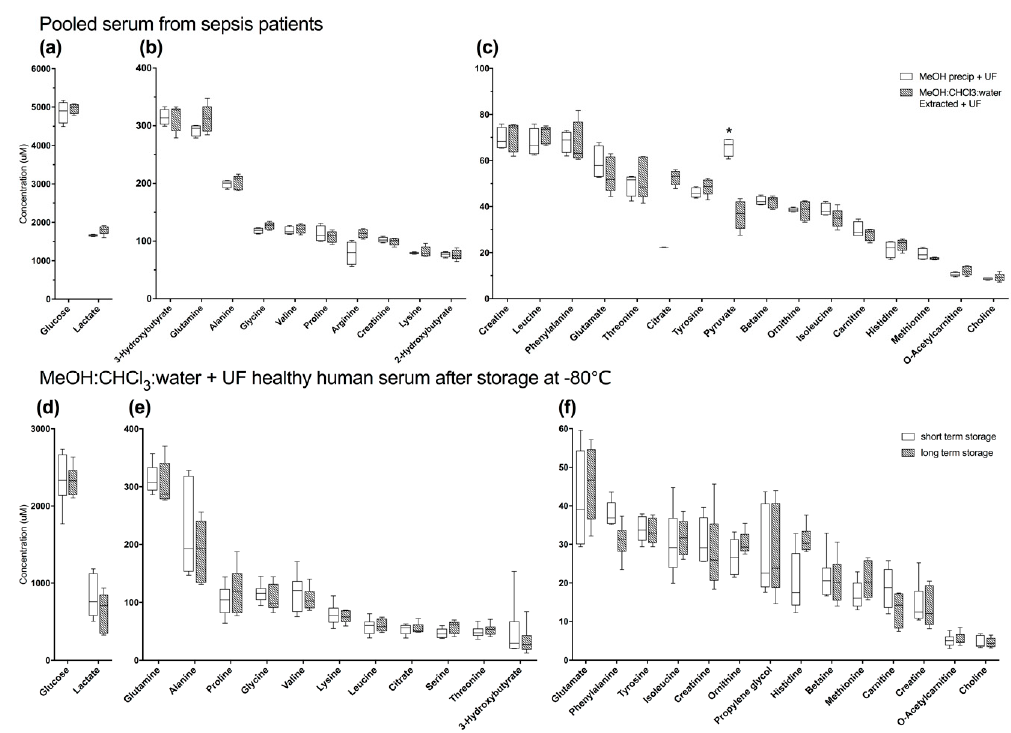
Figure 3. Differences in macromolecule removal strategies were not evident in pooled technical replicates of human serum from patients with sepsis ( a – c ) suggesting that sample collection techniques may influence metabolite recovery ( n = 4 for MeOH ppt +UF, n = 5 for MeOH:CHCl 3 :water ext +UF). All samples were also ultra-filtered. Long-term storage at − 80 ◦ C did not result in changes to detected metabolomes ( d – f ). Box plots represent the interquartile range of all samples in each group ( n = 6 for both storage conditions) with the cross-bar being the median and the whiskers representing minimum and maximum concentrations. ( a , d ) show glucose and lactate; ( b , e ) are high abundance metabolites with concentrations <400–100 µ M; and ( c , f ) are low-abundance metabolites with concentrations <100 µ M. * p ≤ 0.05 by unpaired Student’s t -test of normalized concentration data.